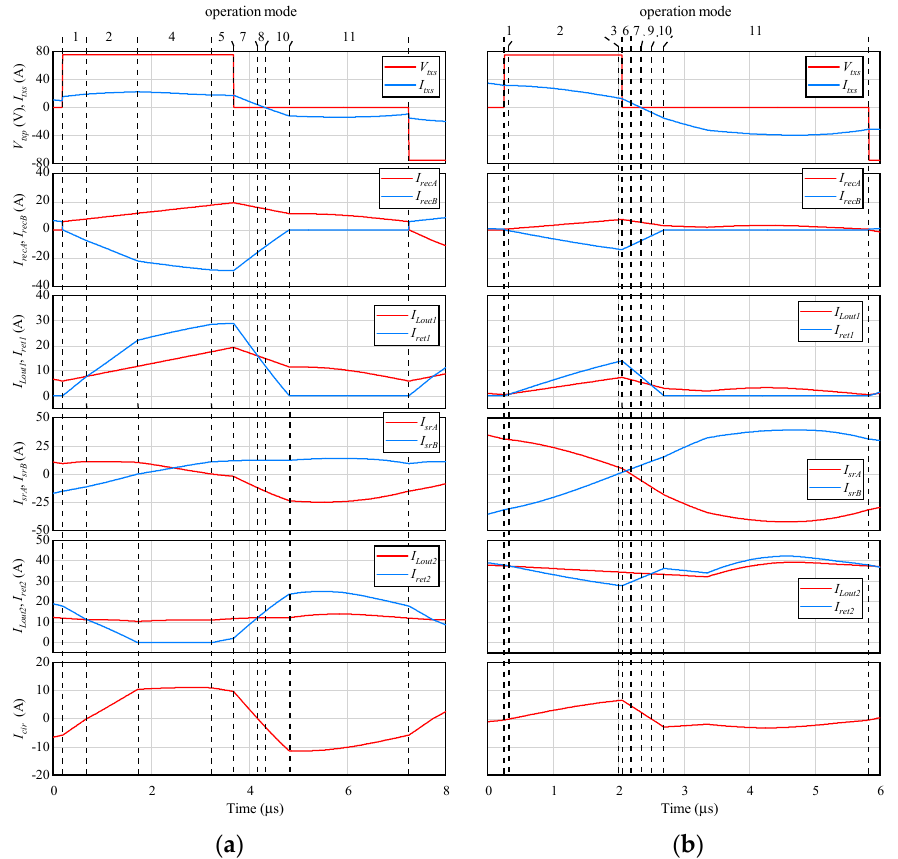
Figure 10. Waveforms of for half period: ( a ) measurement points #04; ( b ) measurement points #12.